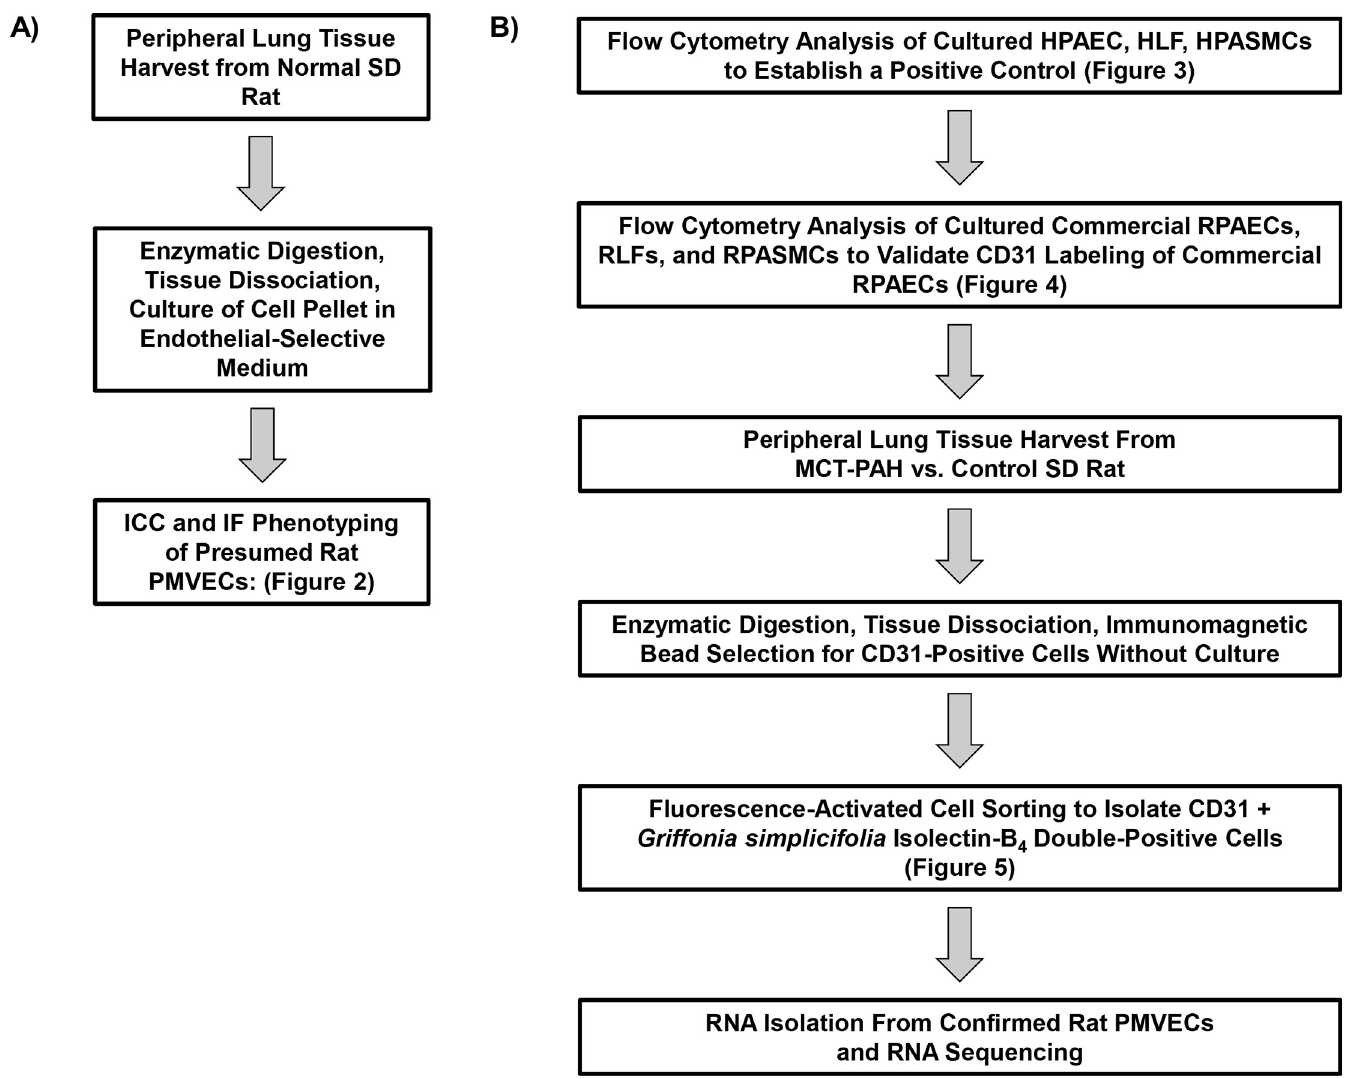
Fig 1. Overall approach to the isolation and phenotyping of rat pulmonary microvascular endothelial cells (PMVECs). (A) Flow diagram of the initial strategy for presumed rat PMVEC isolation and phenotyping by immunocytochemistry and immunofluorescence. ( B) Approach to isolating and confirming rat PMVECs acquired ex vivo by fluorescence activated cell sorting. The figure corresponding to data for a step in the approach is provided. HLF, human lung fibroblast; HPAEC, human pulmonary artery endothelial cell; HPASMC, human pulmonary artery smooth muscle cell; MCT, monocrotaline; RLF, rat lung fibroblast; RPAEC, rat pulmonary artery endothelial cell; RPASMC, rat pulmonary artery smooth muscle cell; rat PMVEC, rat pulmonary microvascular endothelial cell; SD, Sprague Dawley.